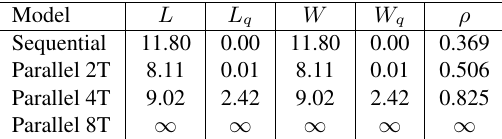
Table 3: Parallelization strategies of Fusion with 32 cores